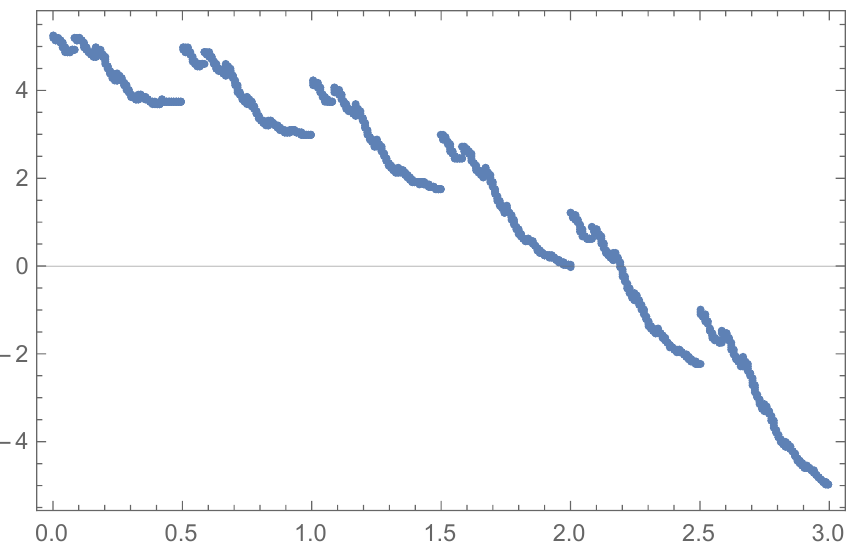
Figure 1. Fractal convolution f ∧ b of the maps f ( t ) = e − 5 t cos ( 3 π t interval I = [ 0,3 ] .